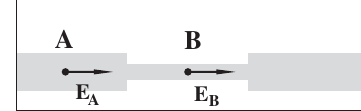
FIG. 6. The electric field at a point outside the thin section is equal to the electric field at a point inside the thin section.